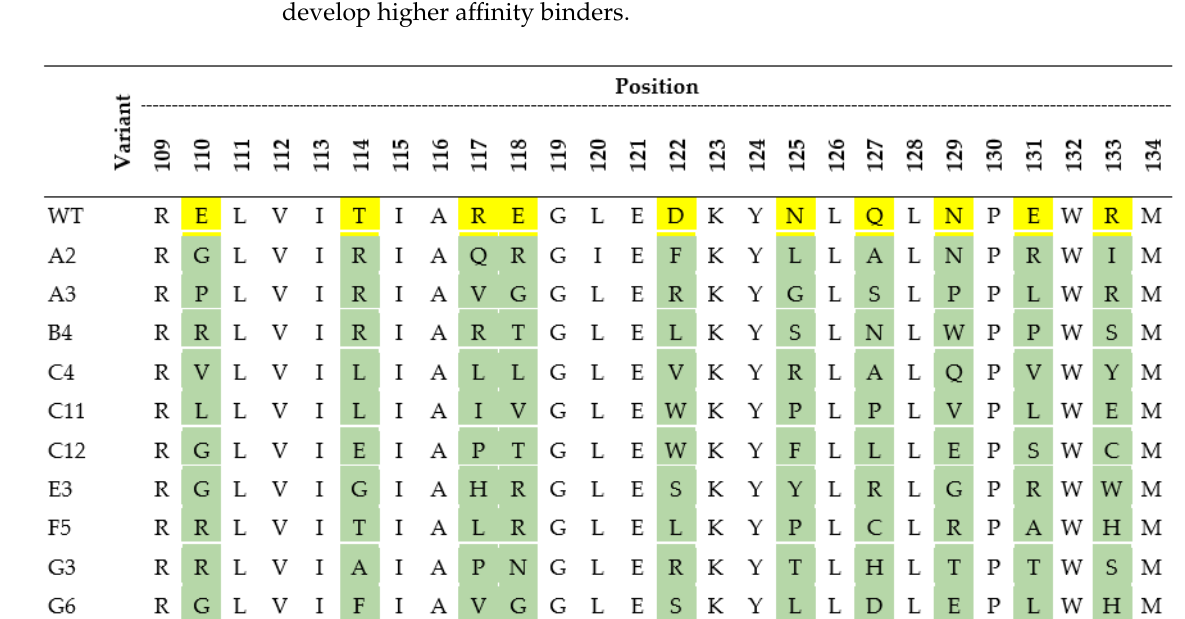
Figure 4. The amino acid sequences of the wild-type (WT) 4PSF protein scaffold and its selected variants with the highest affinity to interleukin-10 and the lowest affinity to interleukin-29, bovine serum albumin (BSA), and skimmed milk. The yellow color represents amino acids of 4PSF-WT protein that were mutated (in green) in scaffold variants. The residue numbering corresponds to the PDB entry 4PSF.